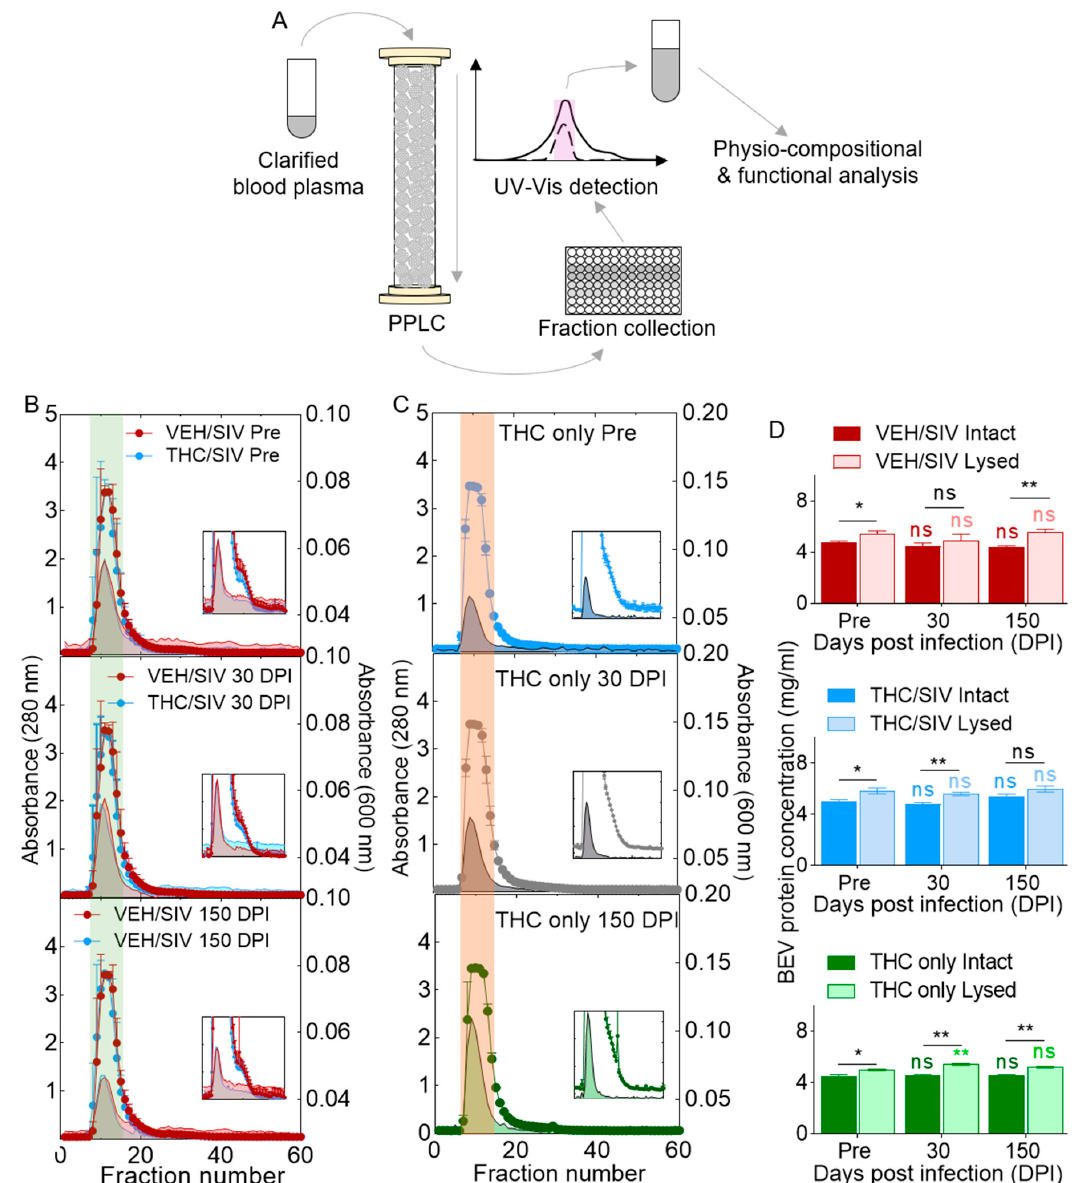
Figure 1. Isolation of BEVs from blood plasma of rhesus macaques (RM): ( A ) schematic of BEV isolation process. UV–vis absorbance profiles for the ( B ) VEH/SIV and THC/SIV groups, and the ( C ) THC ‐ only group. ( D ) BEV protein levels for all clinical groups. Ordinary one ‐ way ANOVA (Brown–Forsythe and Bartlett tests, with Sidak’s multiple comparisons test) was used to determine the statistical significance within the group. Binary Student’s t tests (Welch’s correction) were used to determine significant differences between groups for each of the time points in each group. ** p < 0.01, * p < 0.05, and ns = non ‐ significant.